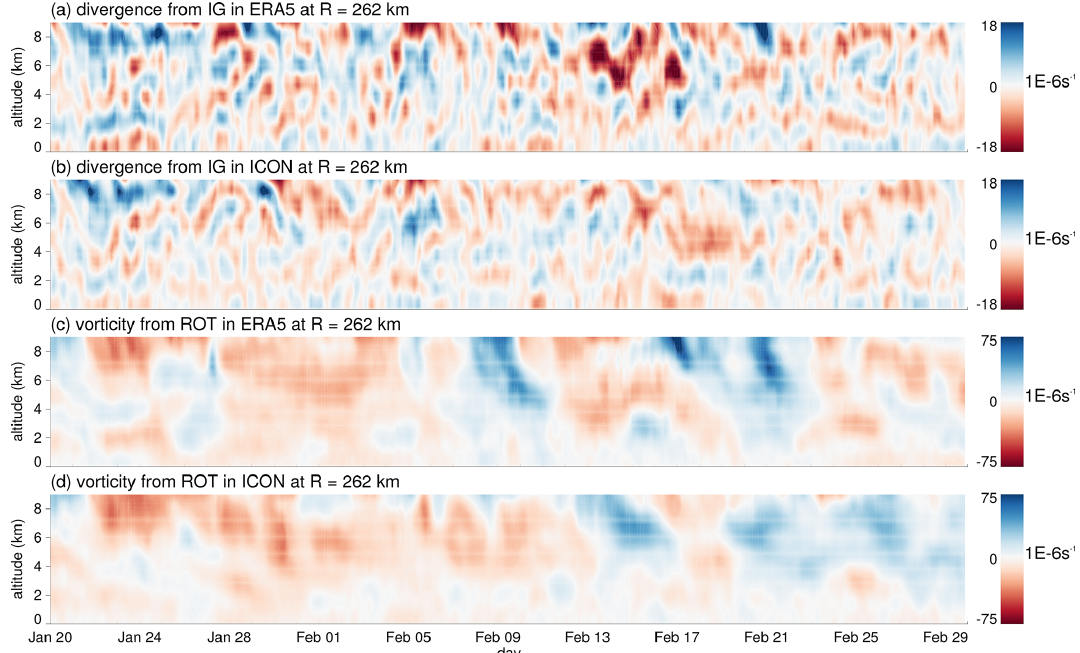
Figure 4. (a, b) Divergence and (c, d) vorticity anomalies associated with (a, b) IG and (c, d) ROT modes in (a, c) ERA5 and (b, d) ICON for an equivalent radius of 262km. The area is centered on ∼ 12 ◦ N, − 57 ◦ E, matching the approximate location of the EUREC 4 A sounding network (compare Fig.